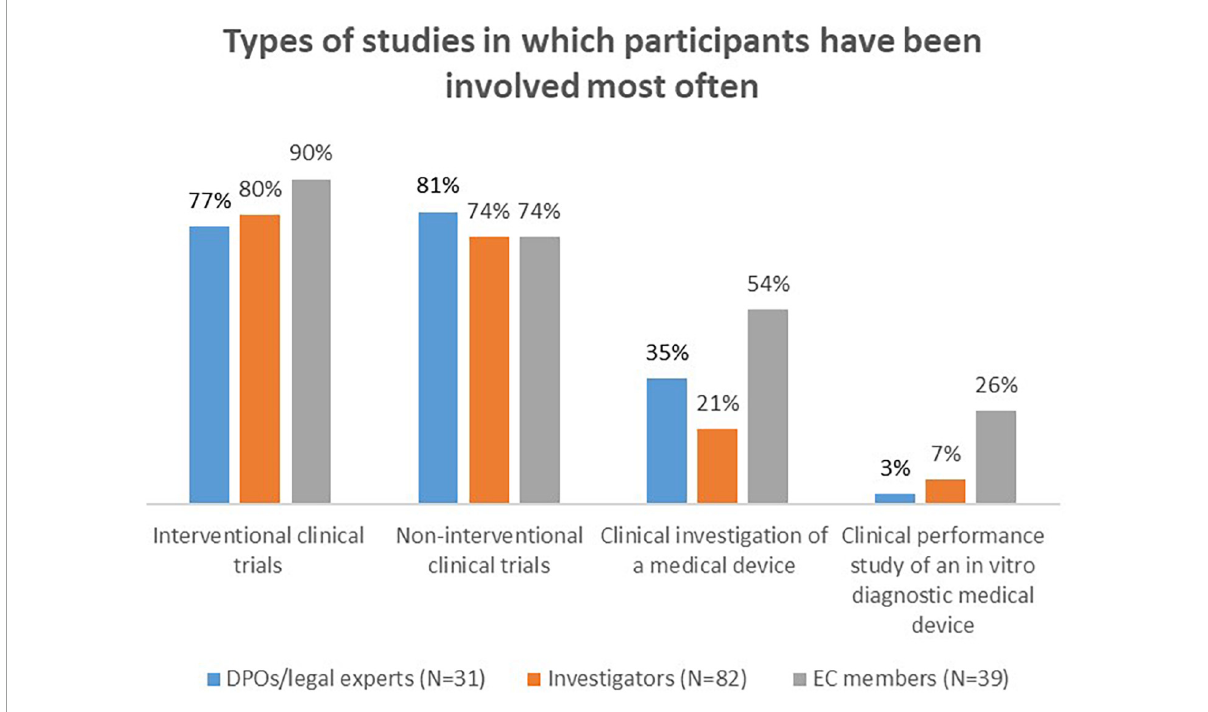
FIGURE1 Types of studies in which survey participants have been involved most